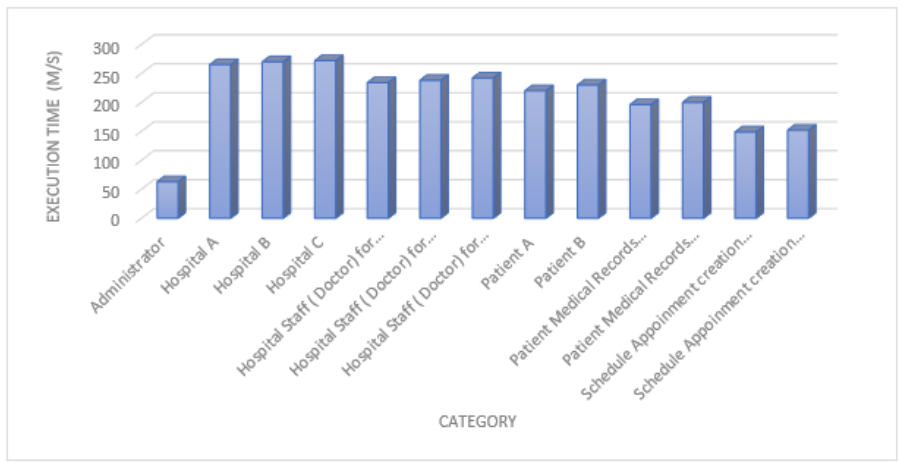
Figure 4. Execution time in